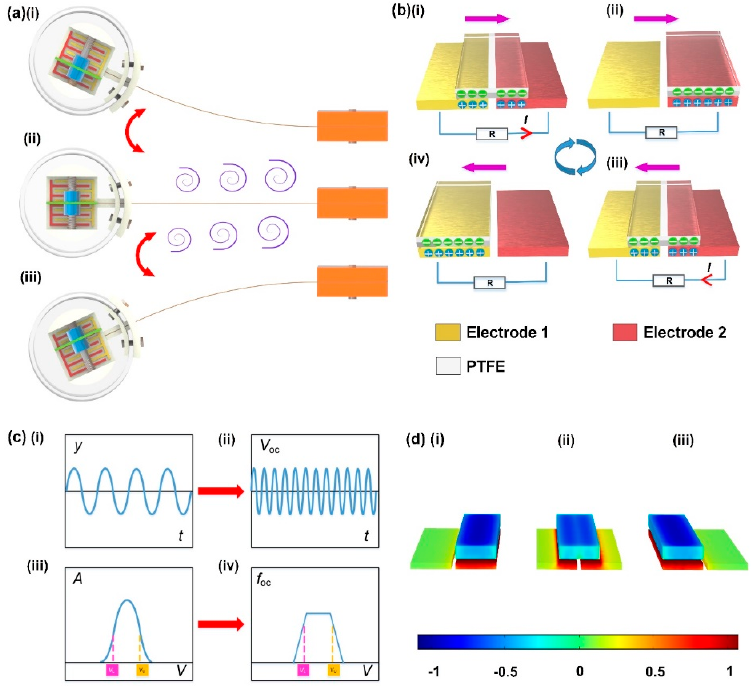
Figure 2. The working mechanism of AVM: ( a ) vortex vibration states of AVM; ( b ) illustration of the working principle of VI − TENG; ( c ) theoretical relationship between vibration signal and electrical signal of AVM: (i) displacement, (ii) open circuit voltage, (iii) amplitude, (iv) frequency; ( d ) simulating potentials of the VI − TENG in three di ff erent states simulated using COMSOL: (i) the state of alignment between the PTFE fi lm and electrode − 1, (ii) the state when the PTFE fi lm is across the two electrodes, (iii) the state of alignment between the PTFE fi lm and electrode − 2.